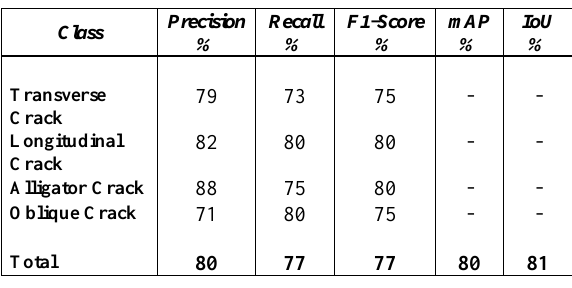
Table 1 . Evaluation results of the proposed network.